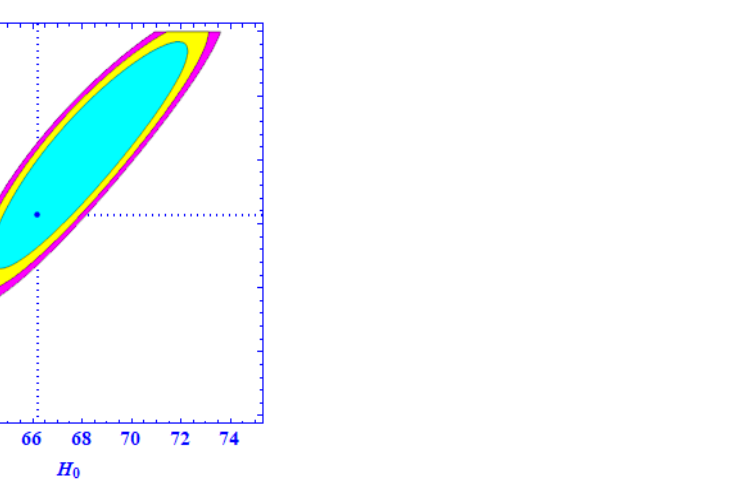
Figure 2. Two-dimensional contours in the H 0 − ( Ω φ ) 0 plane at 1 σ , 2 σ and 3 σ confidence regions by bounding our model with H ( z ) data